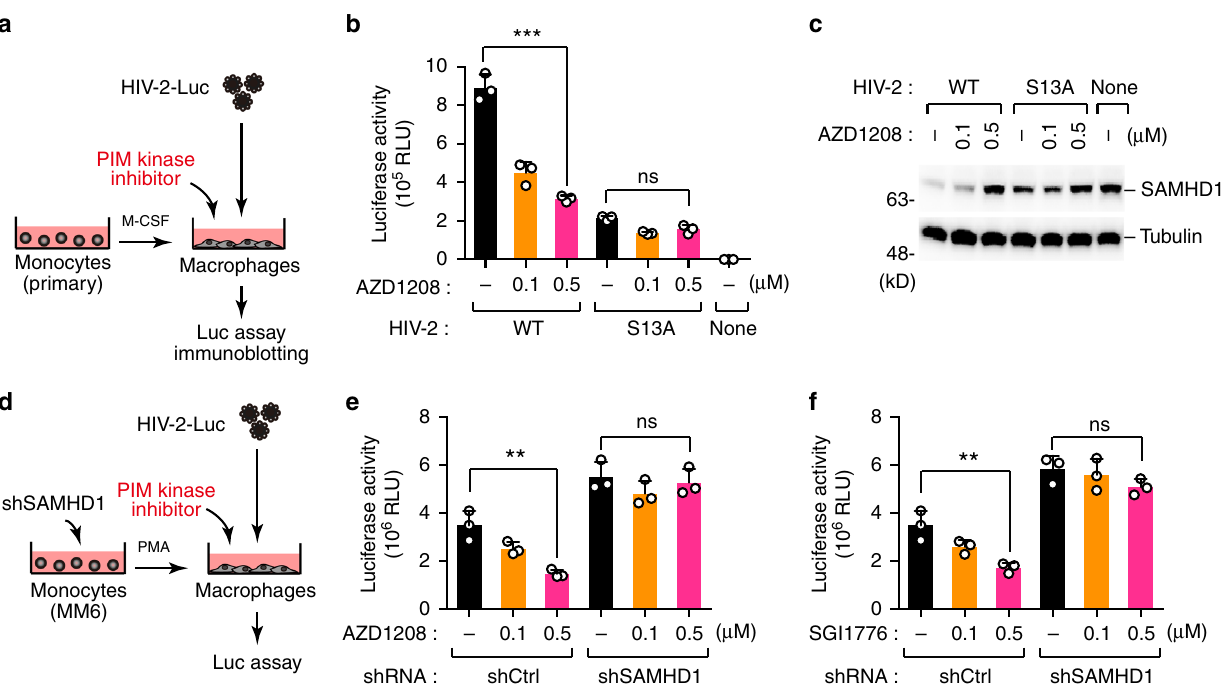
Fig. 6 PIM kinase inhibition prevents Vpx-mediated SAMHD1 degradation. a – c PIM kinase inhibitors block HIV-2 infection in primary human monocyte – derived macrophages. Schematic representation of the experimental design ( a ). Primary monocytes were differentiated into macrophages and infected with HIV-2 reporter virus carrying wild-type Vpx or its S13A mutants. A pan-PIM kinase inhibitor AZD1208 was added 4 h before infection. Forty- eight hours post-infection, cells were harvested and subjected to luciferase assay ( b ) and immunoblotting ( c ) to measure HIV-2 infectivity and SAMHD1 expression, respectively. d – f The effect of PIM kinase inhibitors is SAMHD1-dependent. Schematic representation of the experimental procedure ( d ). Monomac6 (MM6) cells stably expressing shRNAs targeting SAMHD1 were differentiated into macrophages and infected with wild-type HIV-2 reporter virus. AZD1208 ( e ) or SGI1776 ( f ) was added 4 h before infection. Forty-eight hours post-infection, cells were harvested and subjected to luciferase assay to measure HIV-2 infectivity. All graphs are presented as a mean ± s.d. ( n = 3). ** P < 0.01; *** P < 0.001; ns, not signi fi cant, two-tailed unpaired t -test. Source data are provided as a Source Data fi